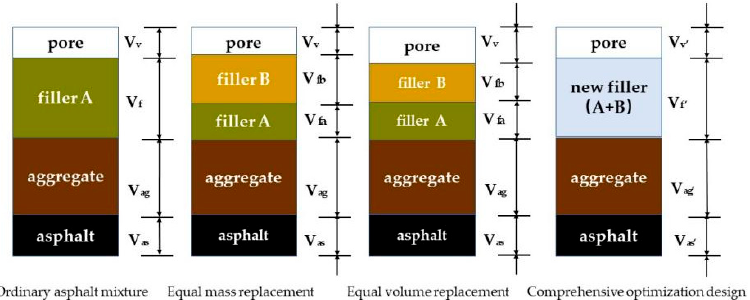
Figure 3. The comparison of salt-storage asphalt mixture mix design.